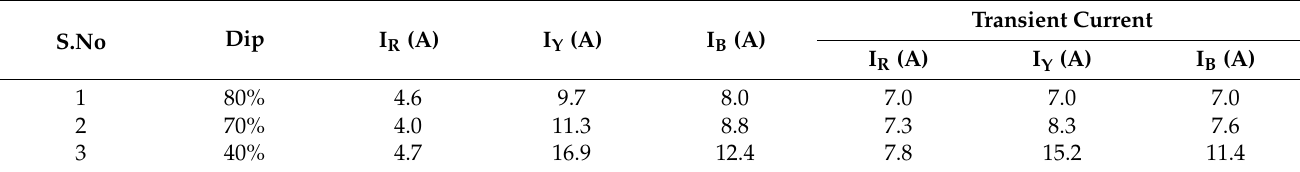
Table 2. Induction motor under loaded conditions [neutral not connected].